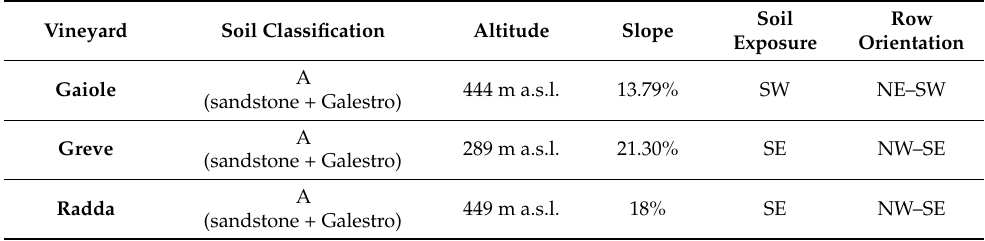
Table 3. Topographical and soil characteristics of the nine vineyards selected.